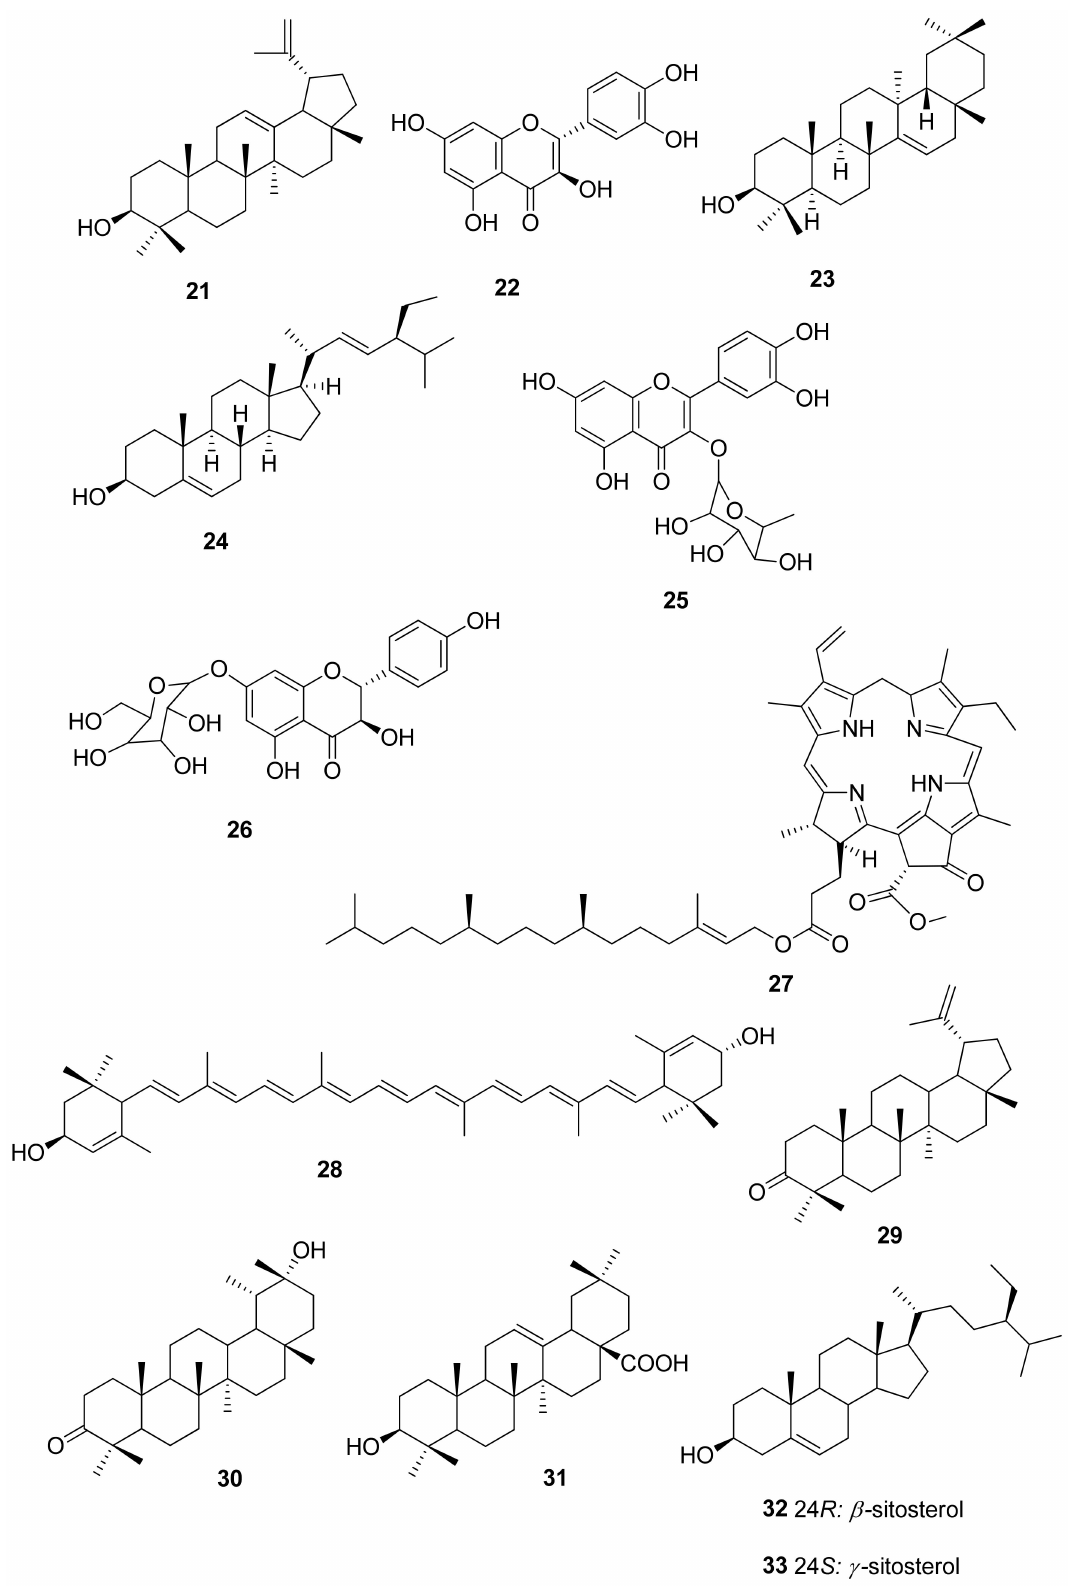
Figure 3. Chemical structures of triterpenoids, flavonoids, alkaloid, and carotenoid isolated from the genus Rhoicissus